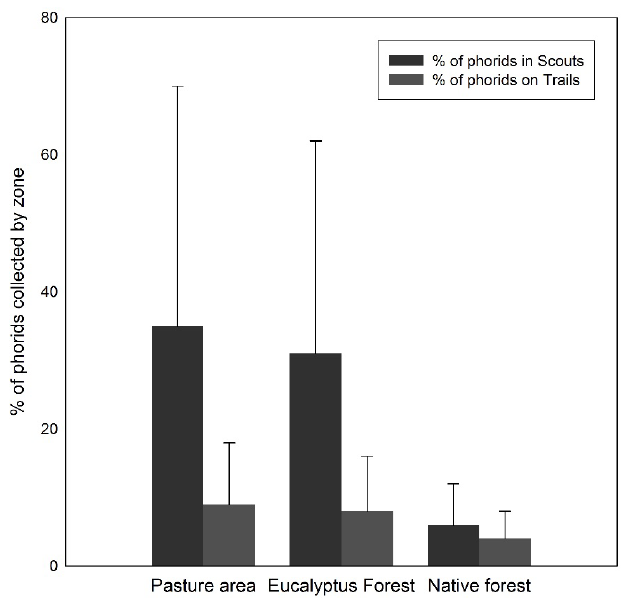
Fig 2. Percentage of phorids collected in each activity zone (scout and